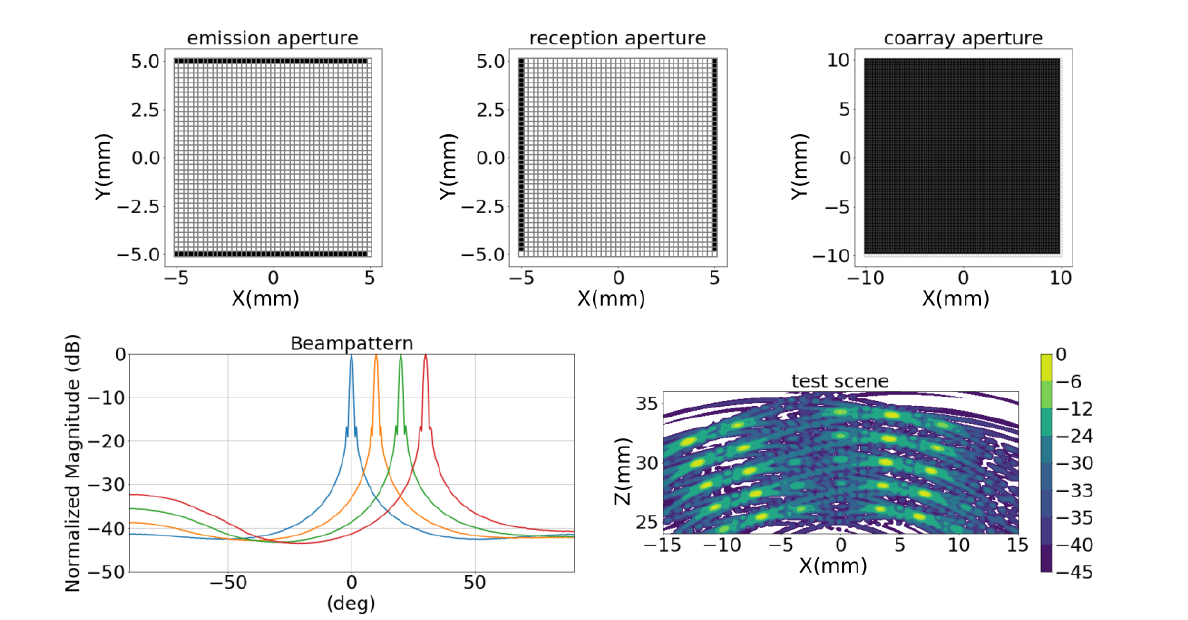
Figure 3. Sparse aperture solution to solve a minimum redundancy coarray. In the top, emission and reception apertures are presented with the resultant coarray. In the bottom-left, the beampattern in the x -axis ( R =100 mm, φ = 0 ◦ ,) is presented at different steering angles (0 ◦ blue, 10 ◦ yellow, 20 ◦ green and 30 ◦ red). In the bottom-right the image generated by this array from the scenario presented in Figure